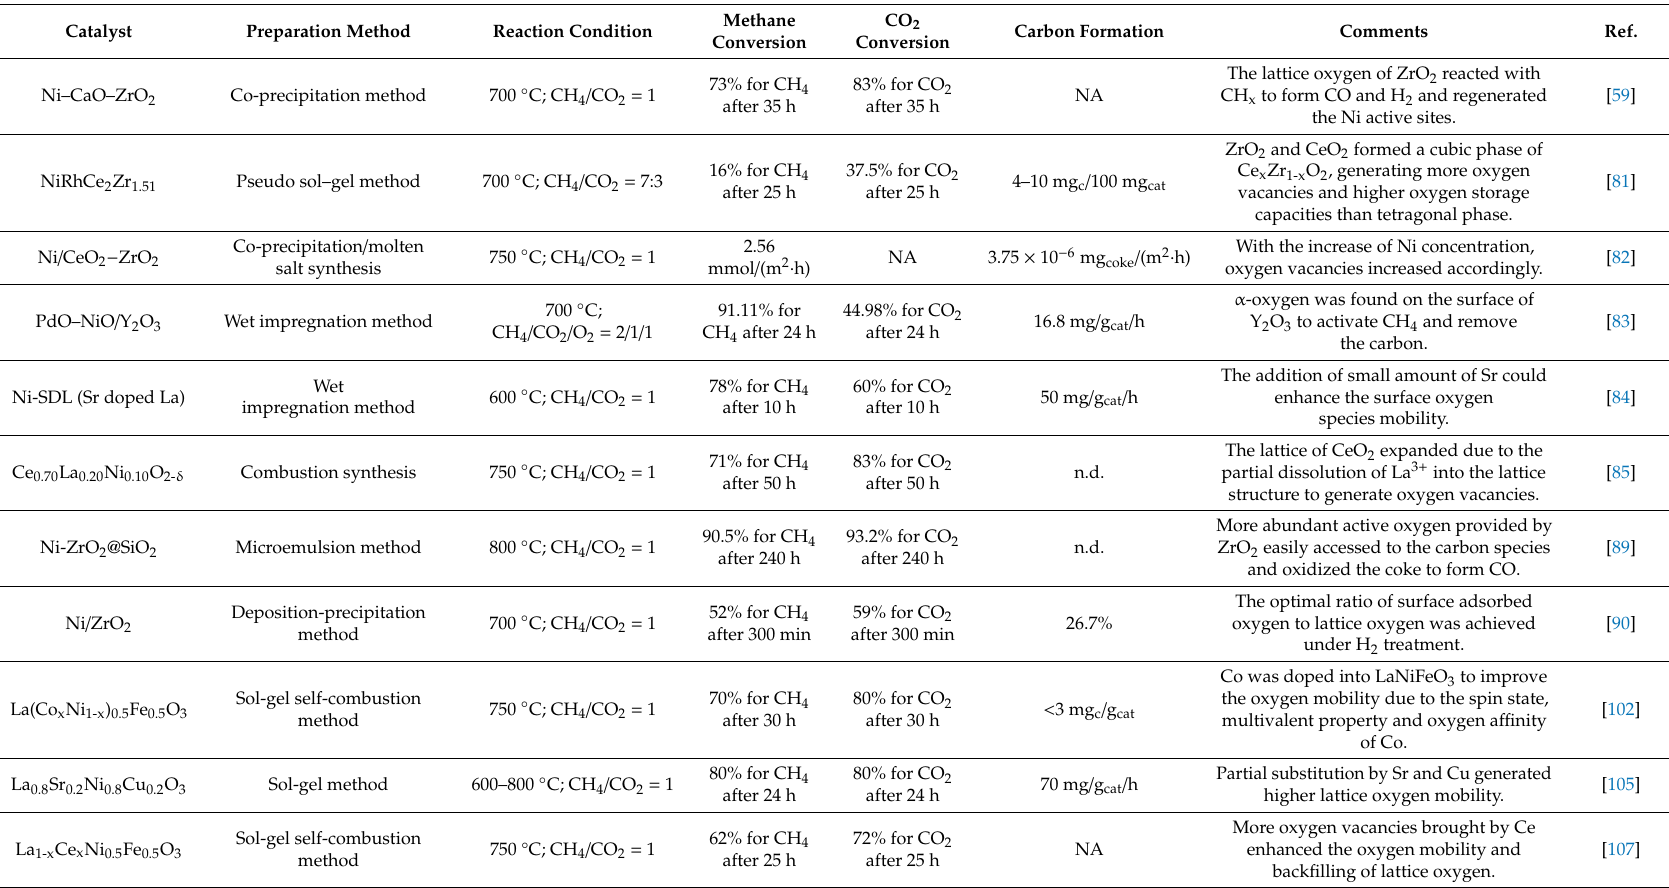
Table 2. A summary of oxygen defects e ff ects on the catalytic performances of Ni-based catalysts for DRM